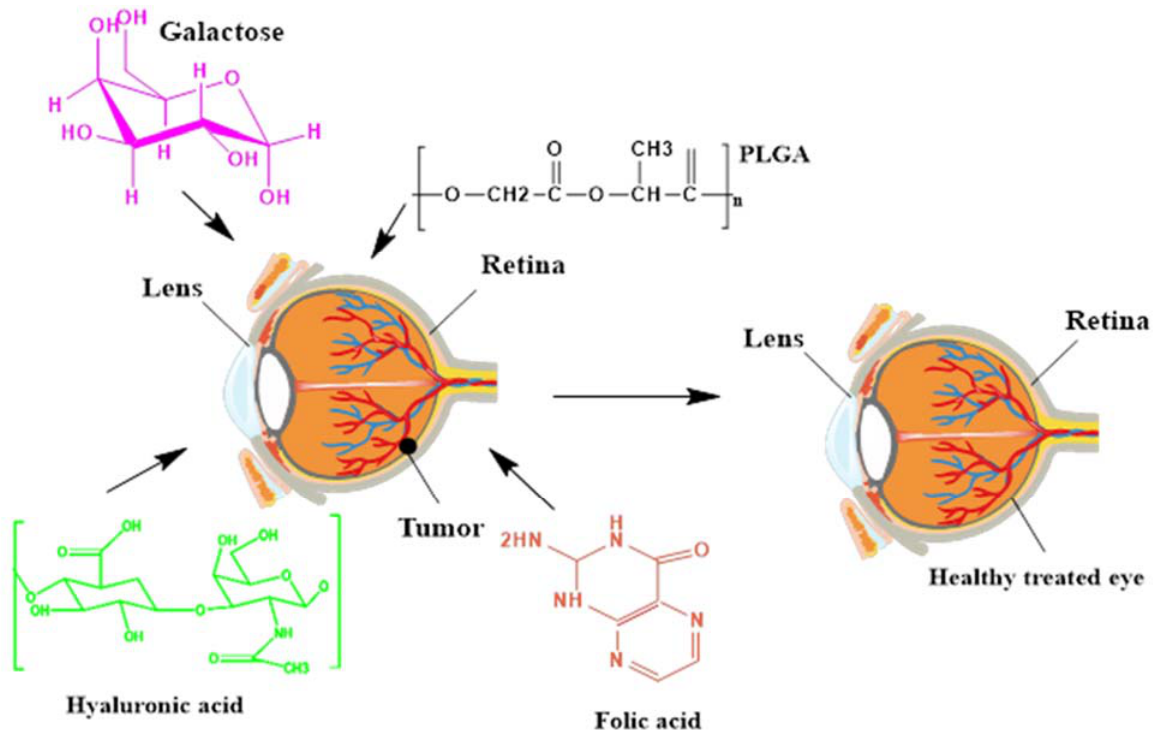
Figure 2. Multi-functionalized ligand-based nanoparticles for targeting retinoblastoma. PLGA: poly-D,L-lactic-co-glycolic acid.